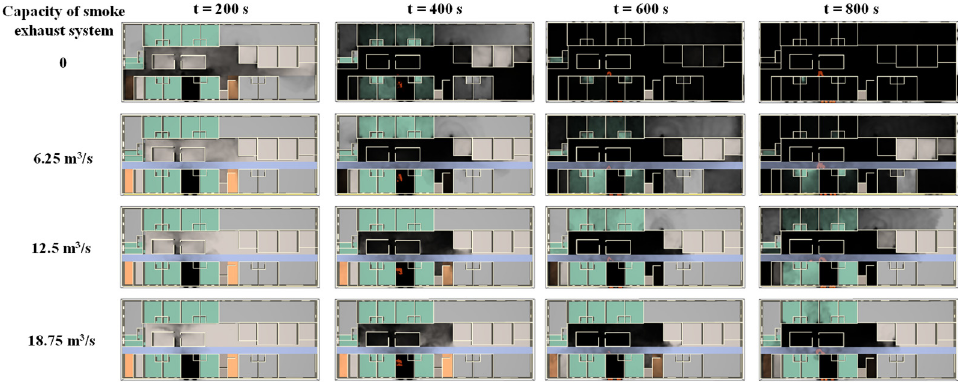
Figure 4. Smoke behavior at 2nd floor according to capacity of smoke exhaust system.